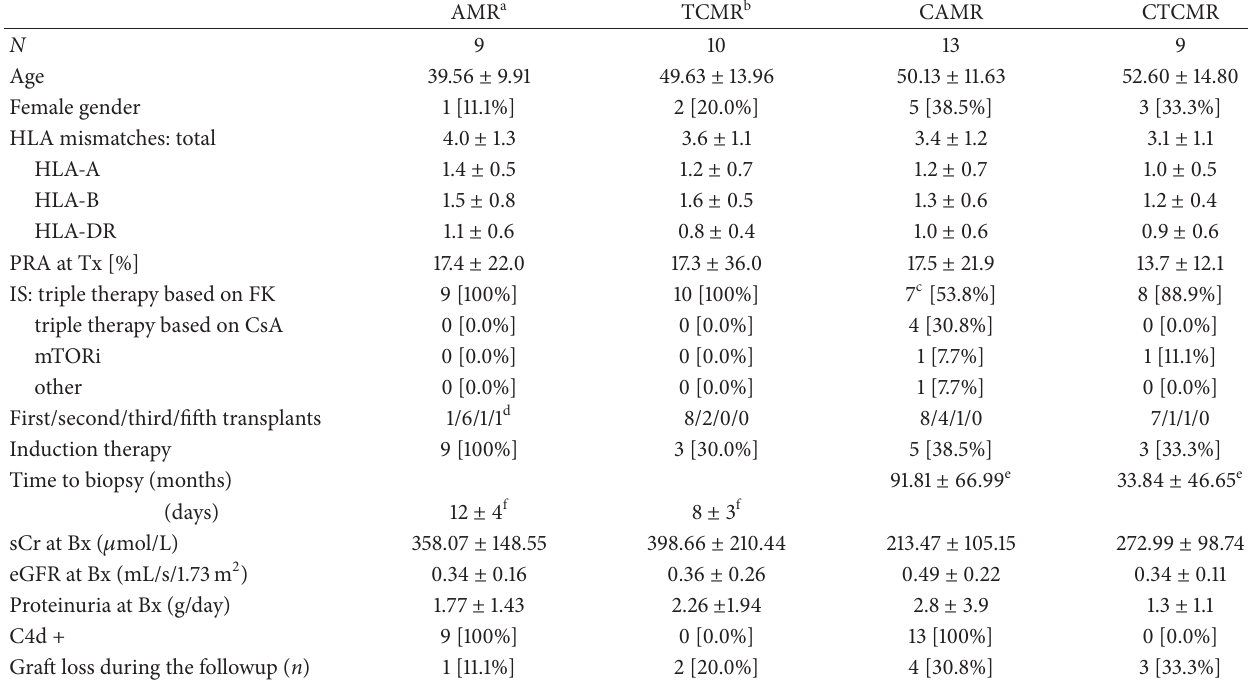
Table 1: Basic patient